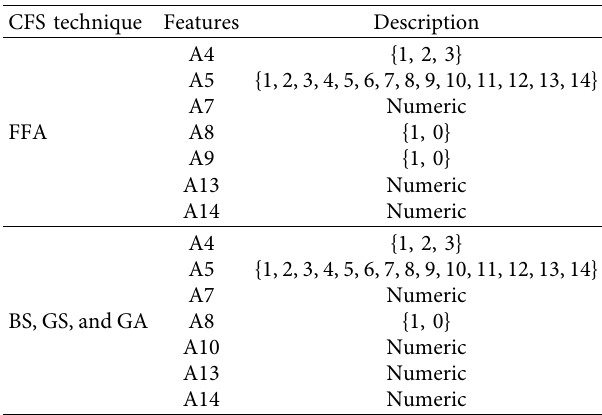
Table 3: Detailed description of a best-selected subset of features that are used for credit card fraud detection.